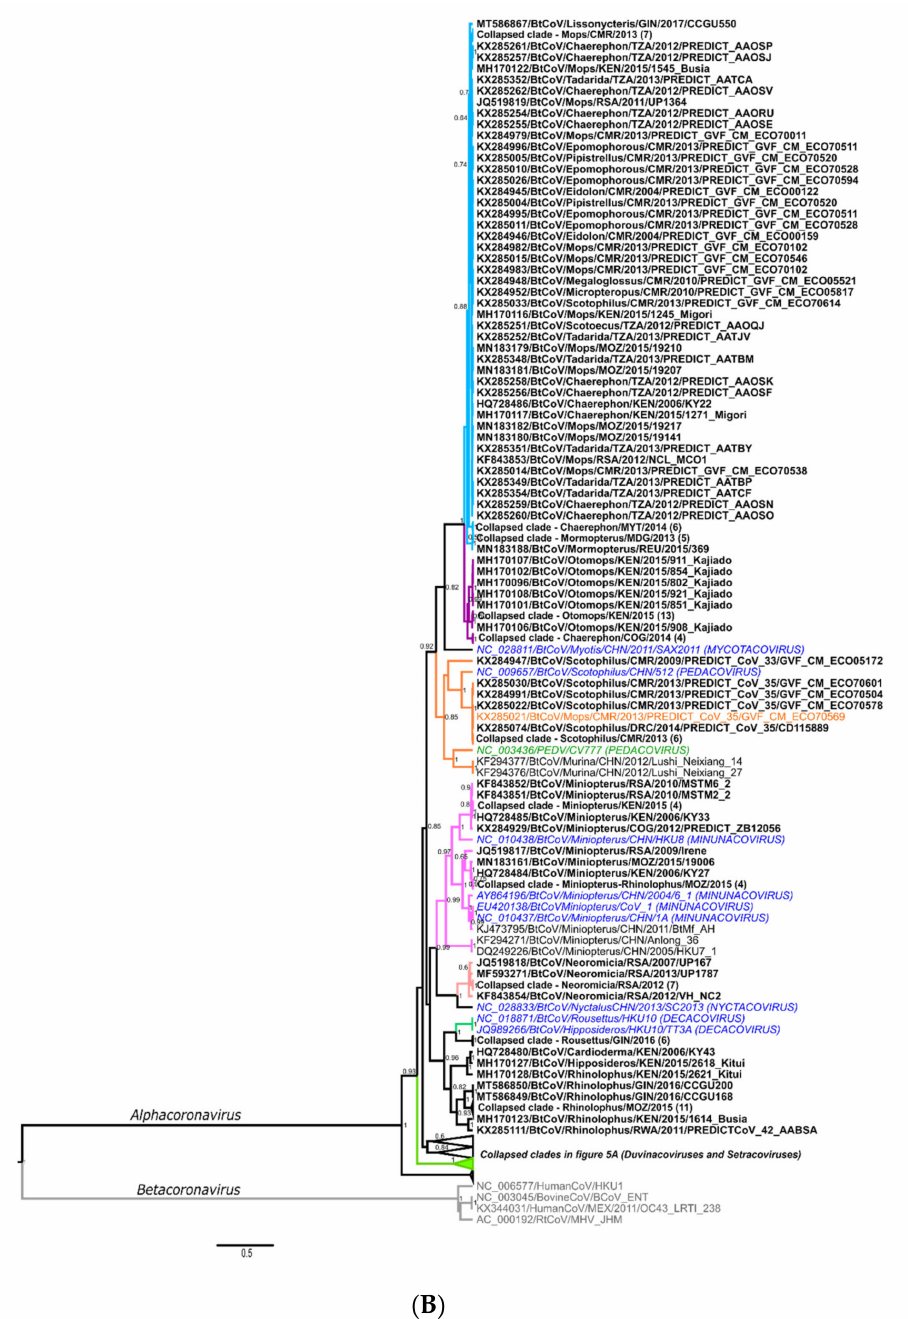
Figure 5. ( A , B ): Alphacoronavirus Bayesian phylogeny of the RdRp partial region (corresponding to approximately 15,200–15,400 nt of the coronavirus genome). Clades collapsed in A are shown in B (and vice versa). To include the maximum number of sequences, sequence lengths were trimmed to a generally useable length of 260 nucleotides. Sequences resulting in shorter lengths were omitted. Sequences in italics indicate formally recognized species (subgenera indicated in capital letters at the end of sequence names); sequences in bold originate in Africa; red highlights human viruses; green indicate non-bat animal hosts; blue/italics indicate formally recognized bat species; orange indicate viral detections from hosts not typically associated with a particular group of coronaviruses. All sequence names were edited to conform to the correct convention, with the modification of the unique sequence identifier listed last due to convenience. Only posterior probabilities of greater than 0.5 are indicated. No unpublished sequences are